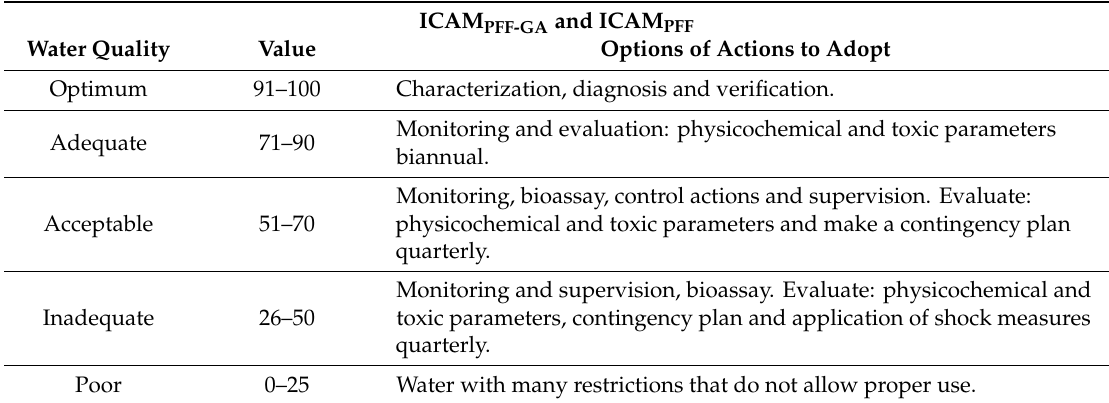
Table 2. Options of actions to adopt. [28].